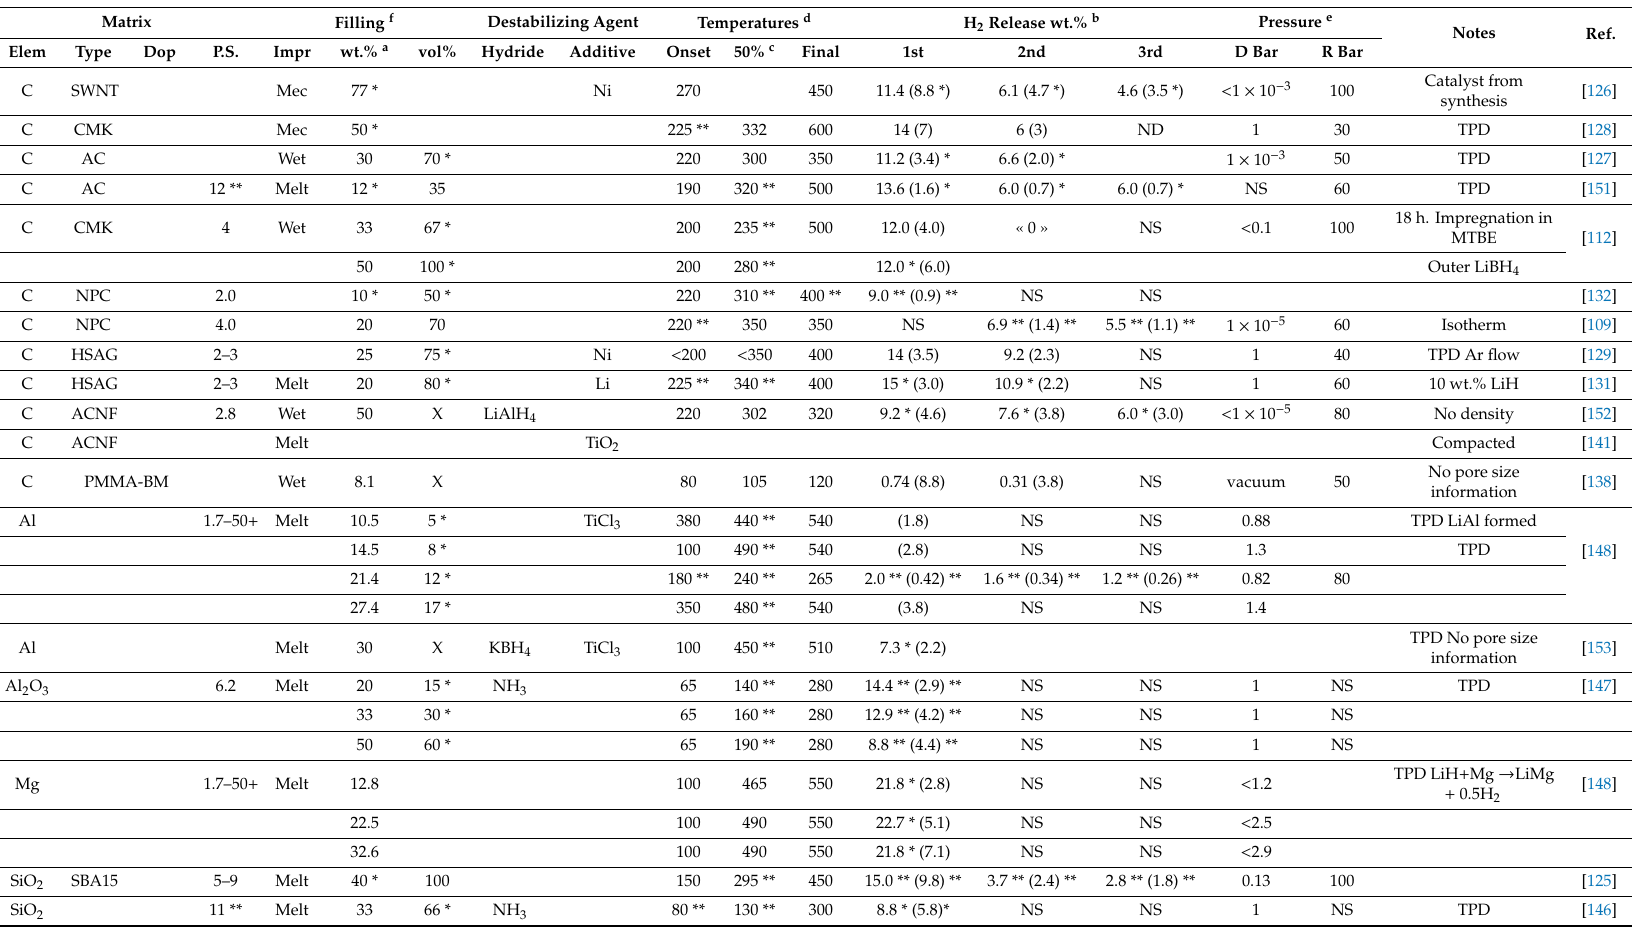
Table 8. Hydrogen storage properties of nanoconfined LiBH 4 -based composites in di ff erent